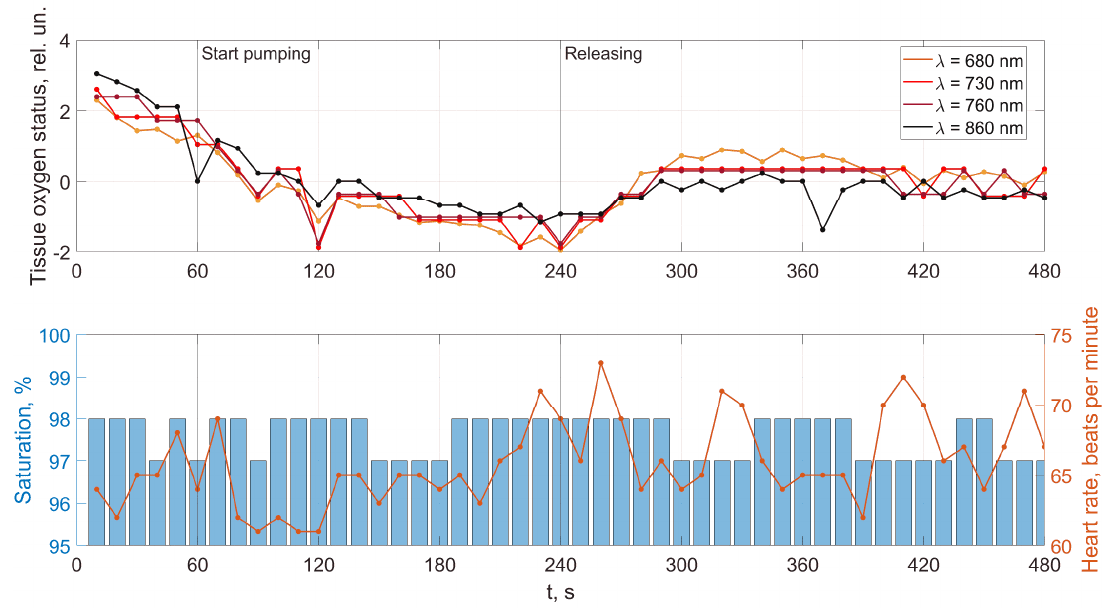
Figure 13. Dynamics of tissue oximetry parameters during the occlusion test for patient (b).